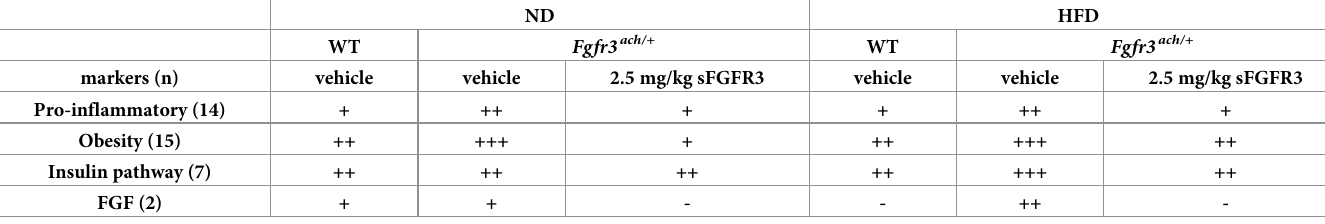
Table 1. Untreated Fgfr3 ach/+ mice displayed an elevated inflammatory baseline prevented by sFGFR3